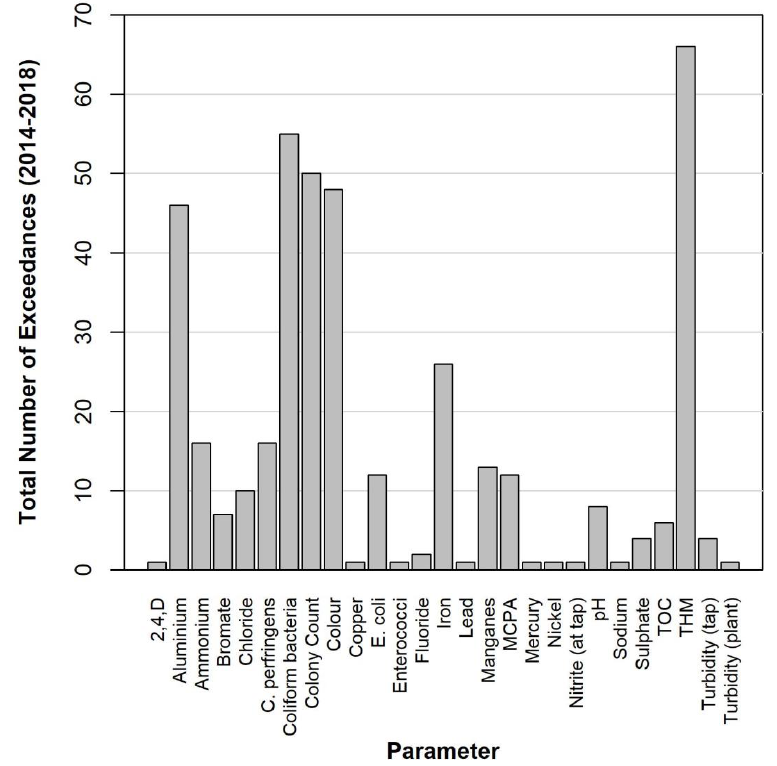
Figure 5. Total number of treated water exceedances of the Drinking Water Regulations (2014) per parameter from privately sourced Group Water Schemes (GWS) between 2014 and